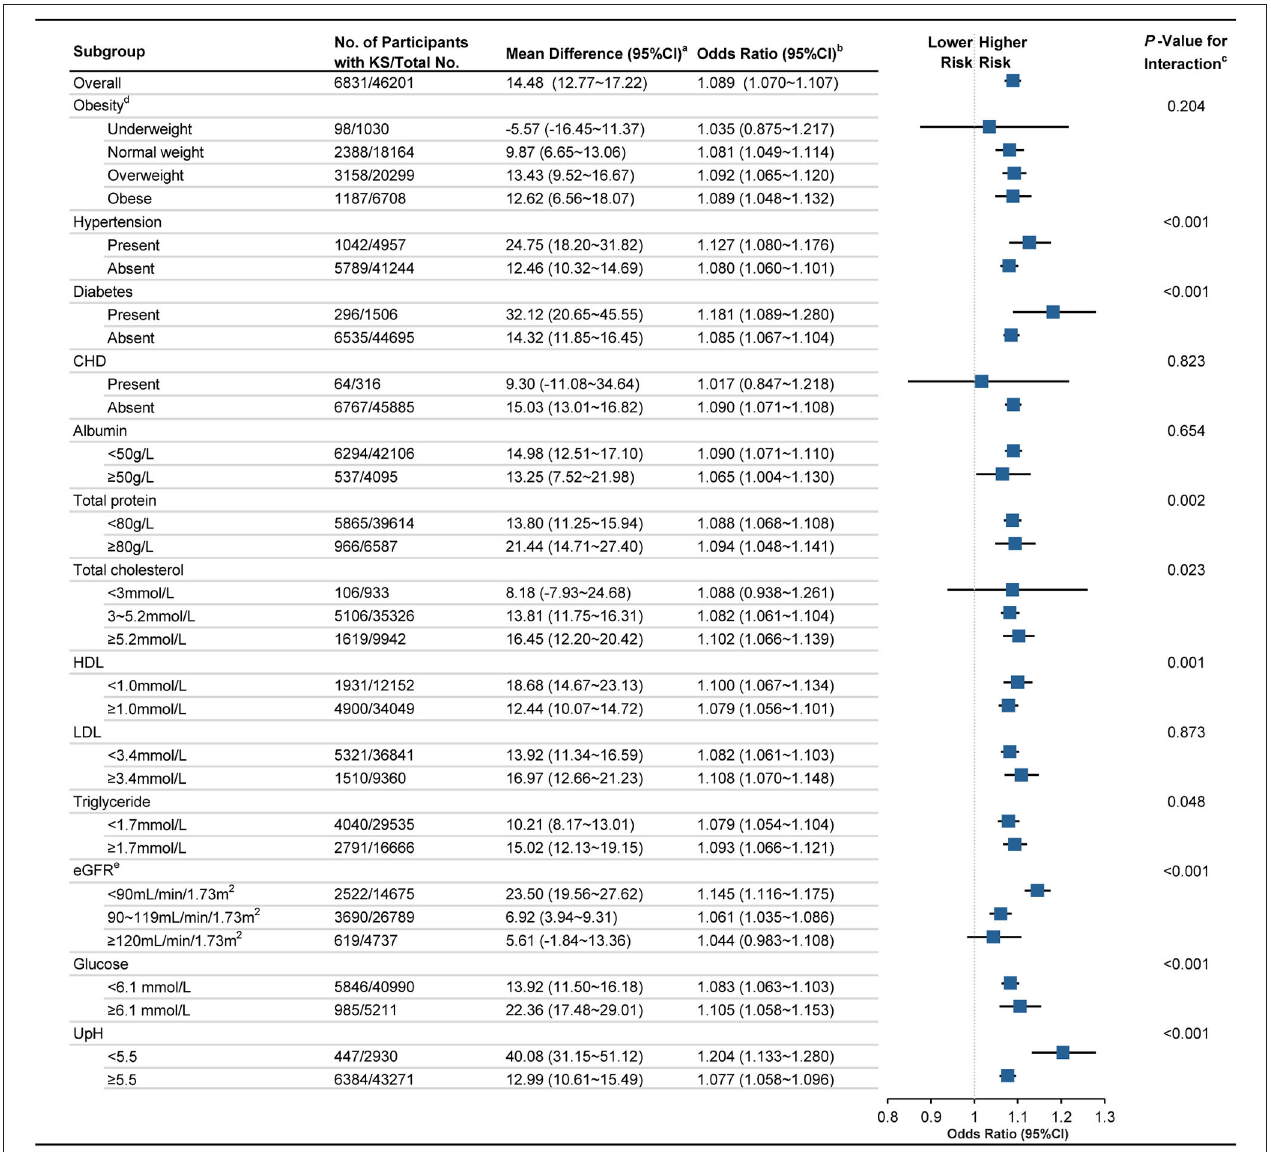
FIGURE 2 | Association between UA level and KS in male population among different subgroups. KS, kidney stone; CI, confidence interval; CHD coronary heart disease; HDL, high-density lipoprotein cholesterol; LDL, low-density lipoprotein cholesterol; eGFR, estimated glomerular filtration rate; UpH, Urine pH. a Calculated applying bootstrap method. Details can be found in Methods-Statistical analyses Section. b Calculated applying model 3 (as shown in Methods-Statistical analyses Section for descriptions of model 3) and taking per 50 µ mol/L UA as a unit. c Calculated by applying Wald test. d Classified according to the recommendation defined by Working Group on Obesity in China. e Calculated using the CKD–EPI equation. Details can be found in Methods